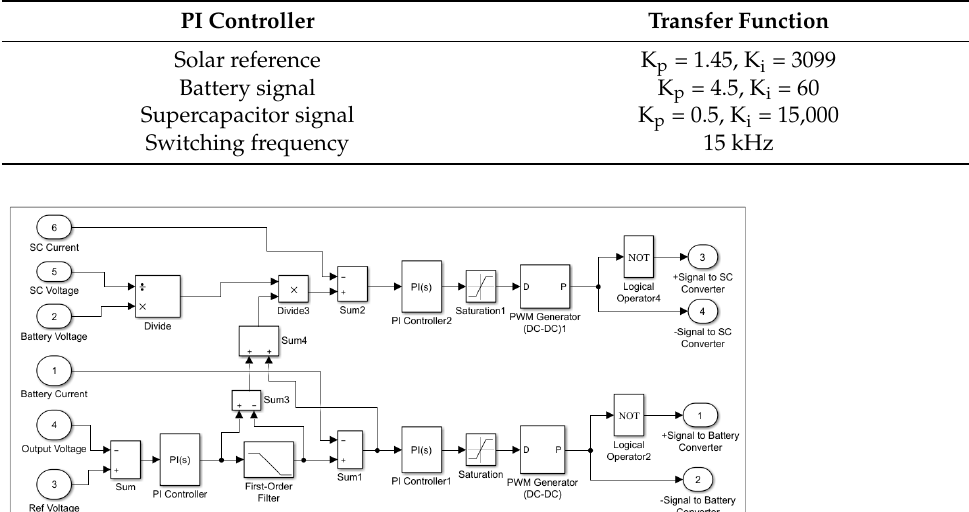
Table 6. Parameters of bidirectional controllers.